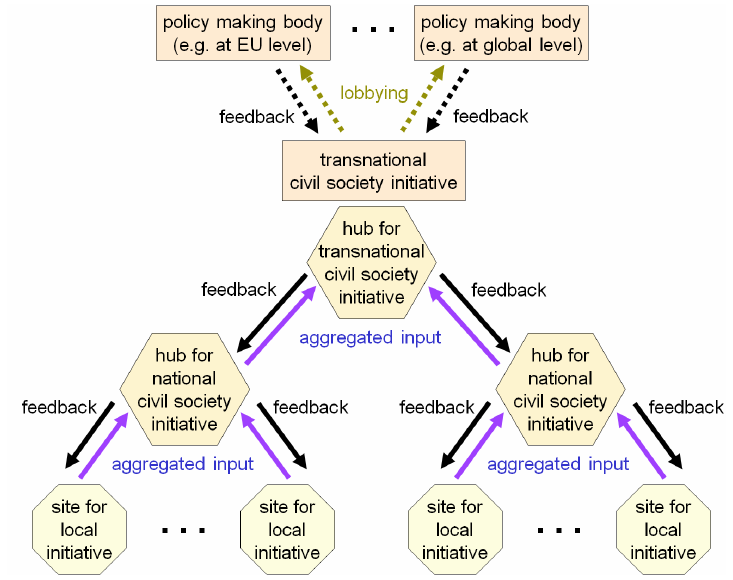
Figure 4: Another example of interaction between sites and